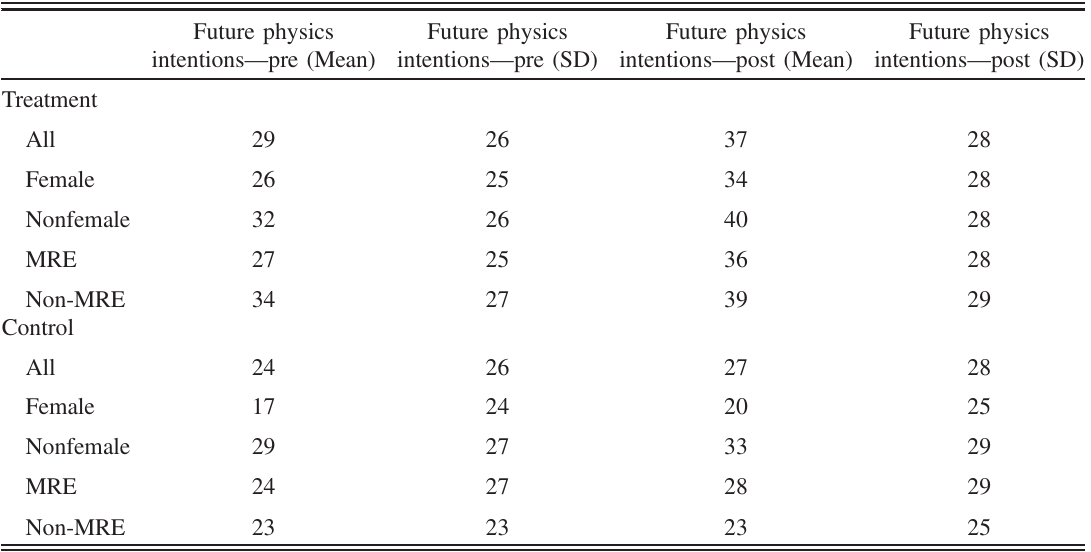
TABLE XI. Summary of Study 2 measures, by demographic group and condition. Percentages quoted represent pre- and postfuture physics intentions (representing the entire range of possible responses, scaled from 0 to 100), after imputation ( m ¼ 100